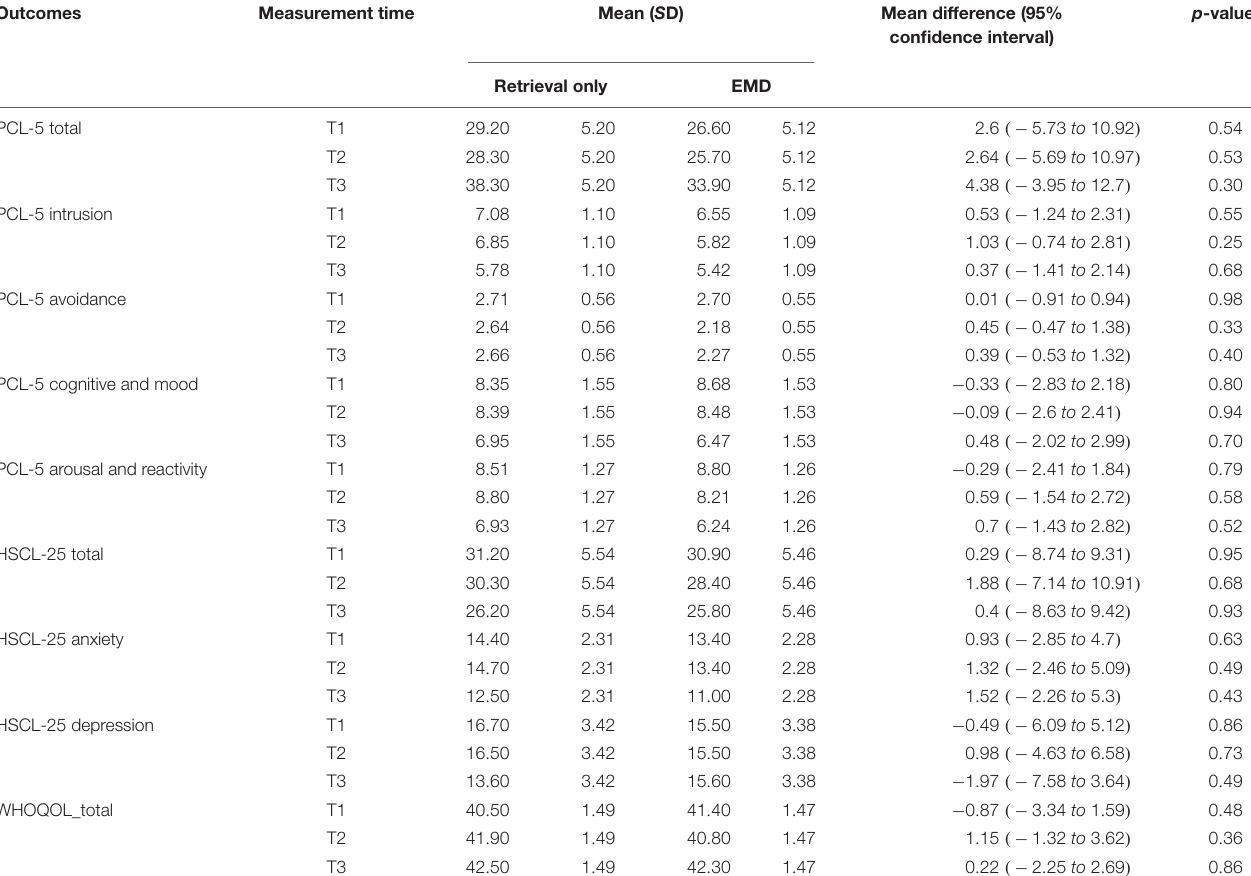
TABLE 2 | Summary statistics and results from mixed-model analysis for symptoms of PTSD, anxiety, depression s and quality of life (Intention-to-Treat sample, N = 91). Outcomes Measurement time Mean ( S D) Mean difference (95%